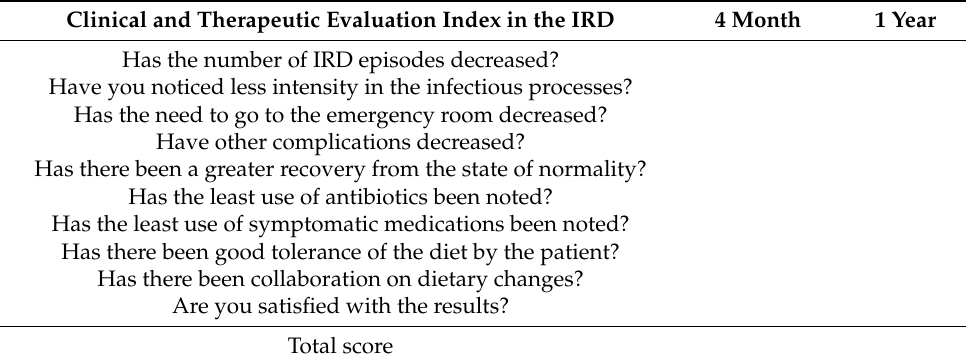
Table A1. Responses from parents or guardians regarding the improvements observed in IRD: 3: much, 2: quite, 1: something, 0: